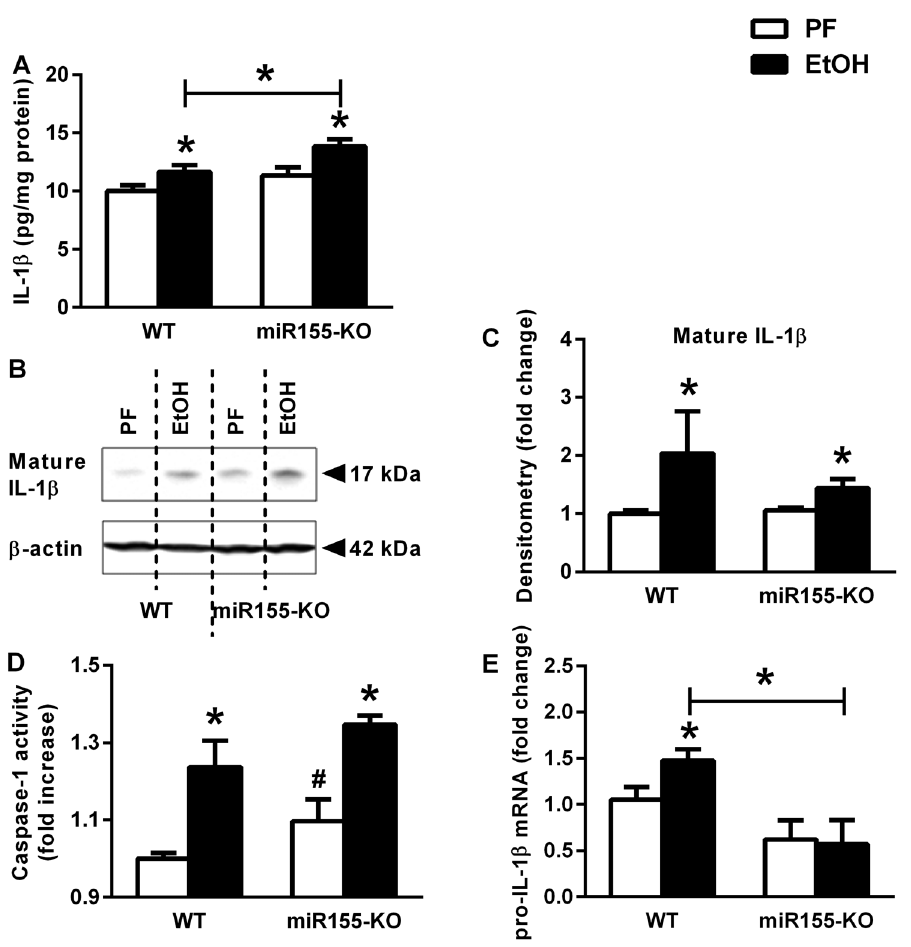
Figure 3. MicroRNA-155 KO mice are not protected from alcohol-induced IL-1 b increase in the cerebellum. WT (n=6 or 7) or miR-155- KO (n=5 or 10) mice were fed with control (PF) or EtOH diet for 5 weeks, respectively. Inflammatory cytokine, IL-1 b was measured by specific ELISA on whole cerebellar lysates and corrected with total protein (A). Mature IL-1 b protein of whole cerebellar lysates was assessed by Western blot using b -actin as loading control (B), and further quantified by densitometry (C) which represents six to ten samples per group. The inflammasome activity was measured by caspase-1 colorimetric assay from whole cerebellar lysates and corrected with total protein (D). Pro-IL-1 b mRNA was assessed by real-time PCR from whole cerebellar RNA extract, corrected with 18S (E). Bars represent mean 6 SEM (*, # : p value , 0.05 relative to appropriate PF or WT controls, respectively, by Kruskal-Wallis non-parametric test).